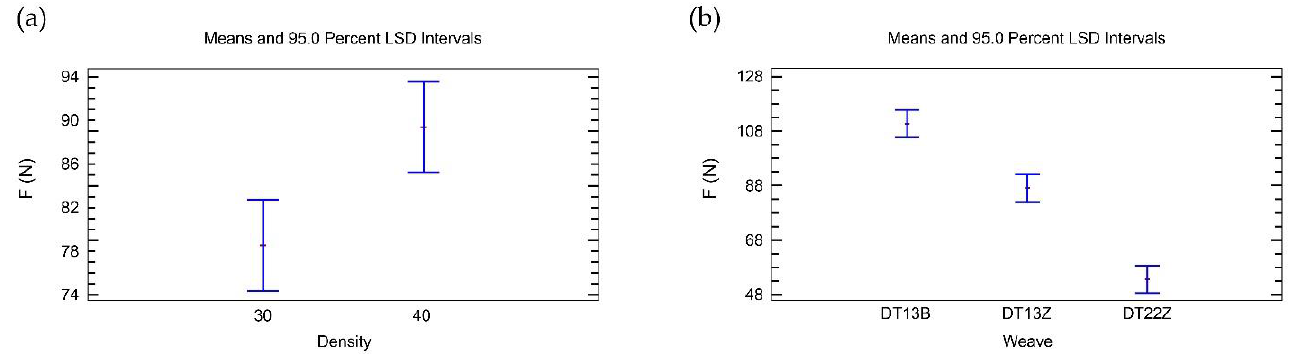
Figure 5. Influence of the main factors on the adhesion force for double fabrics for z1: ( a ) density; ( b ) weave.